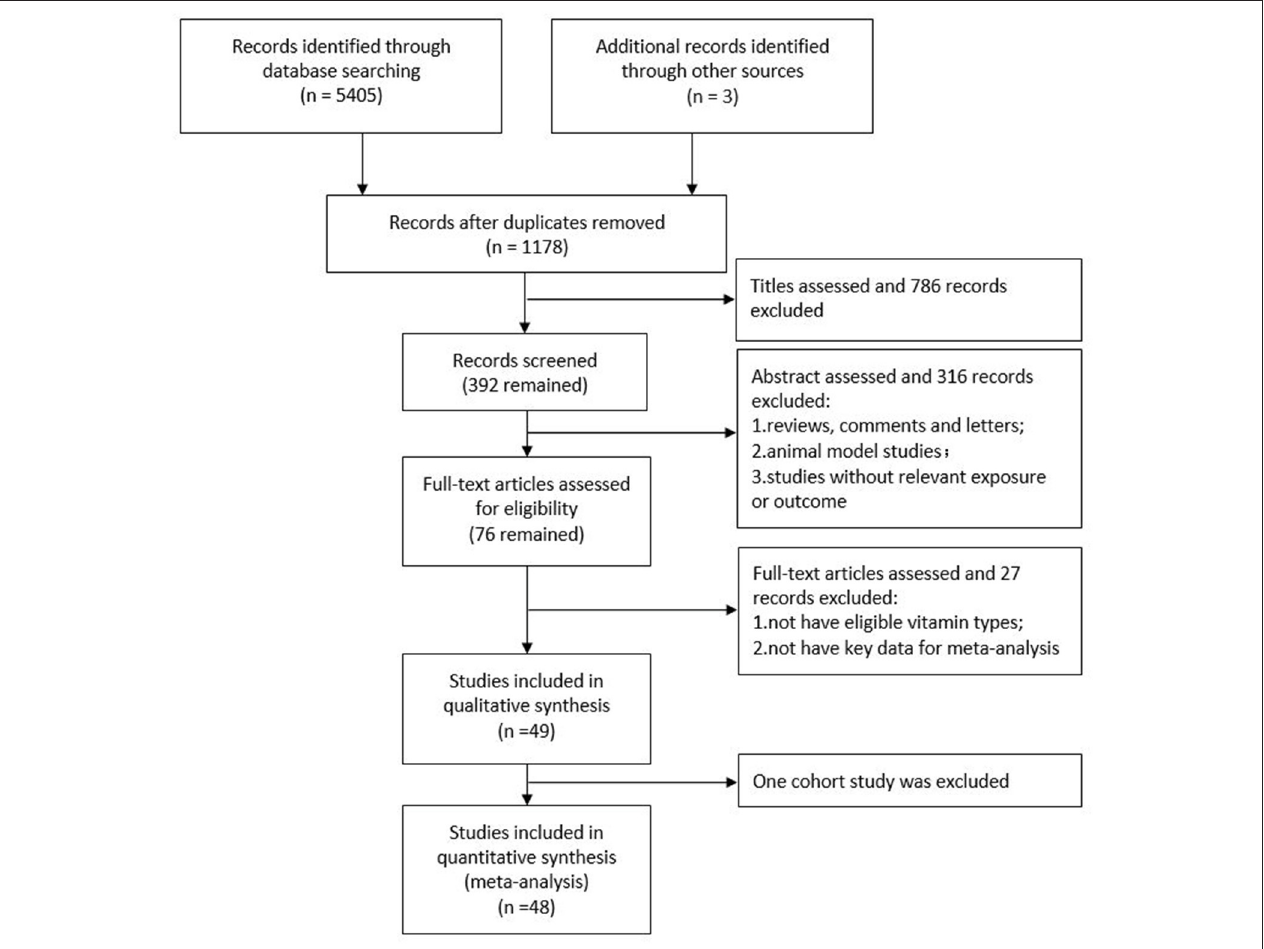
FIGURE 1 | Flow diagram of the studies search